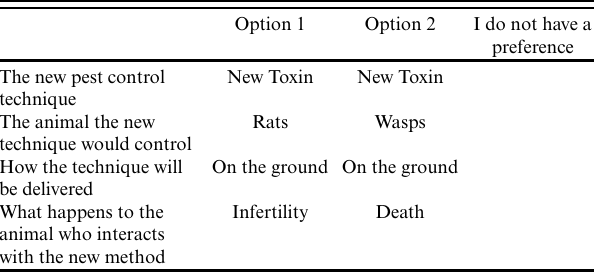
Table 3 . Example of a choice